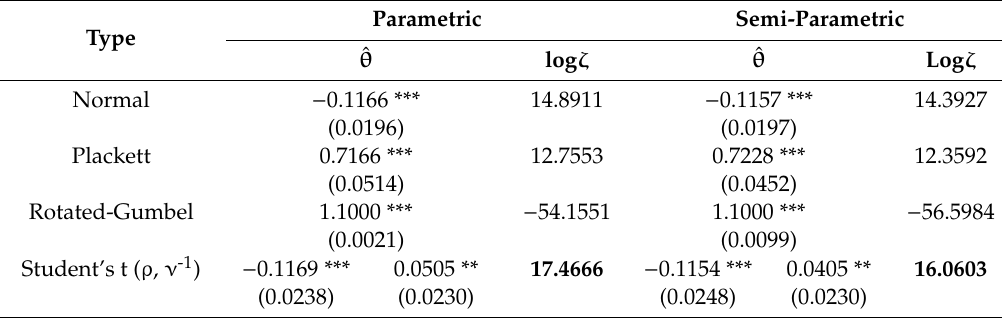
Table 8. Constant copula parameter estimation (Indian Rupee—INR).